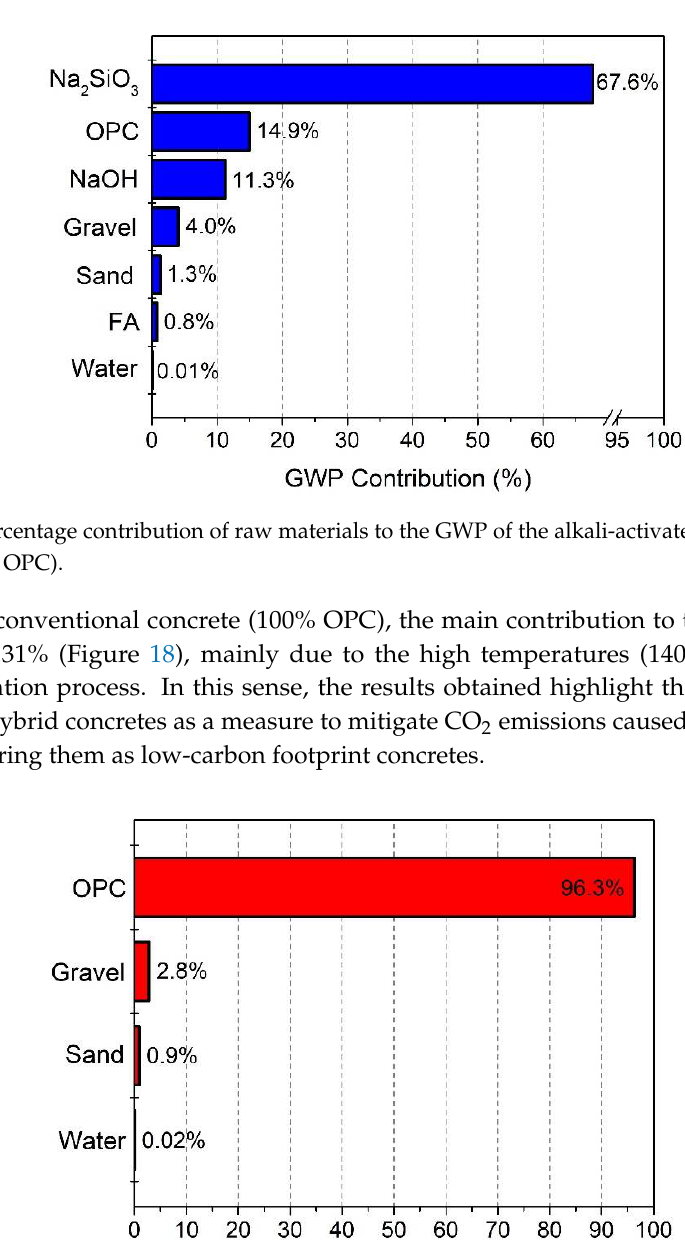
Figure 18. Percentage contribution of raw materials to the GWP of the conventional 100% OPC-based